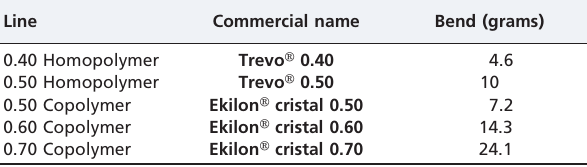
Table 1 - Nylon lines and their respective bends in grams.